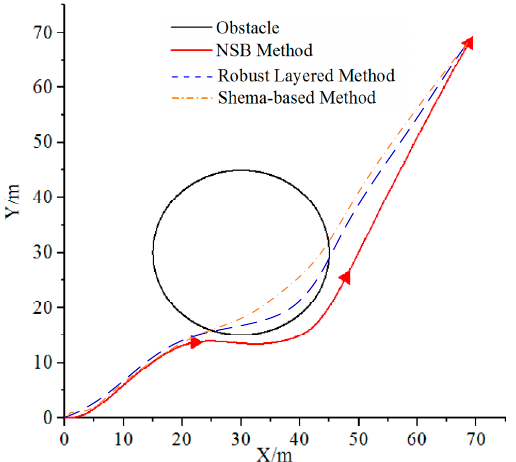
Figure 11. Obstacle avoidance of different methods.